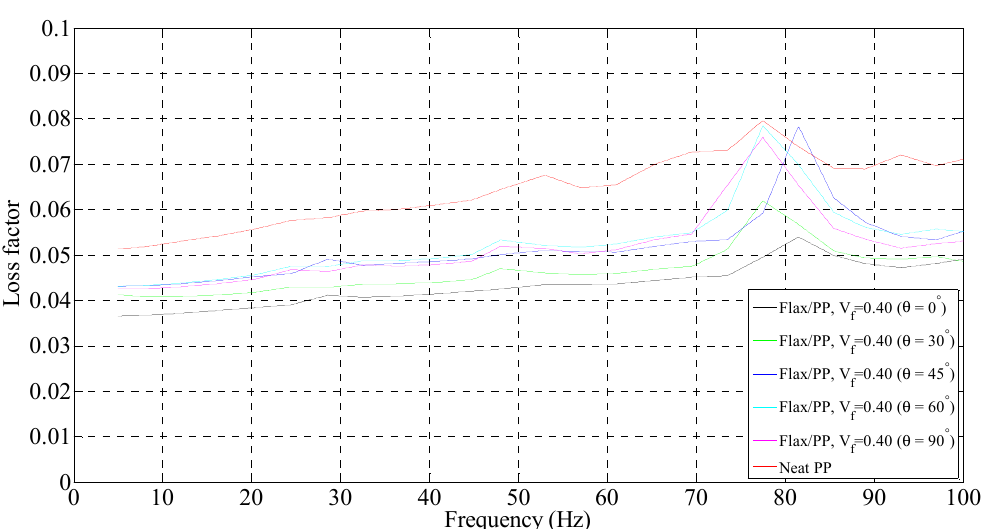
Figure 8. Loss factor of flax/PP composite samples of different fibre orientations for a fibre volume fraction of 0.40 and a neat PP sample.